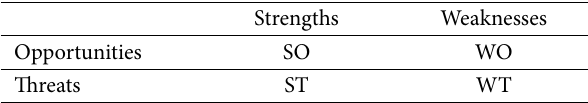
Strengths Weaknesses